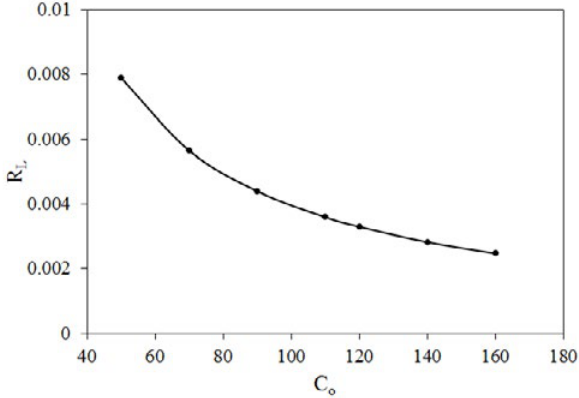
Fig. 11: Variation in R Fig. 11. Variation in R L with respect to C o of adsorption of MB.